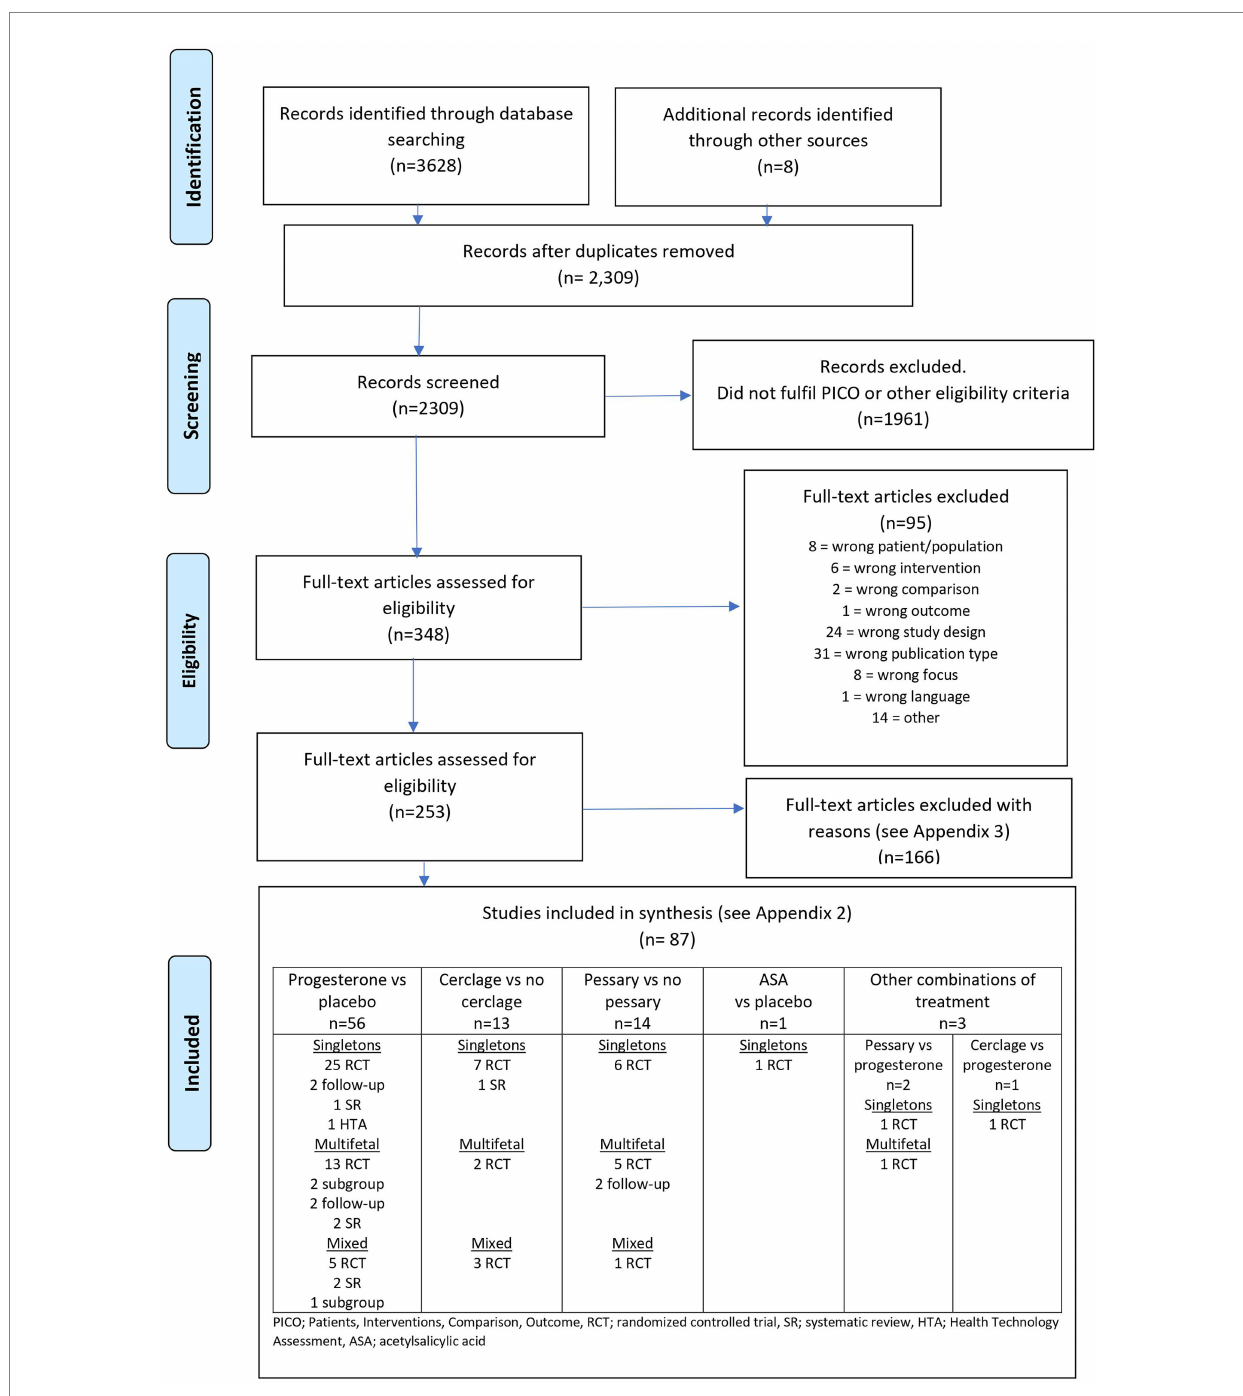
FIGURE 1 Flow diagram presenting the selection process after the literature search (all